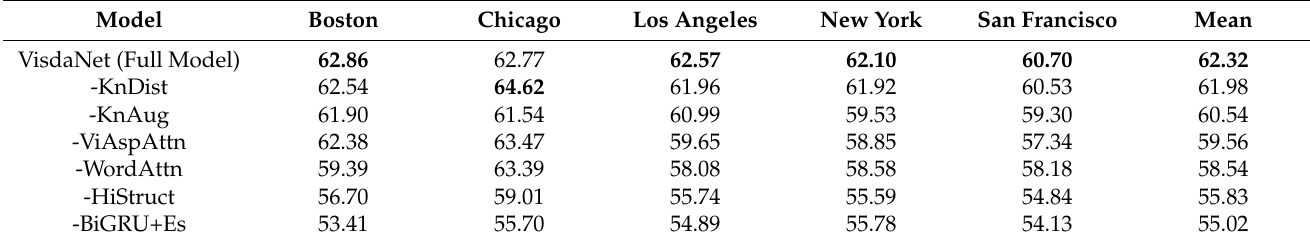
Table 7. Comparison results in architecture ablation analysis experiments